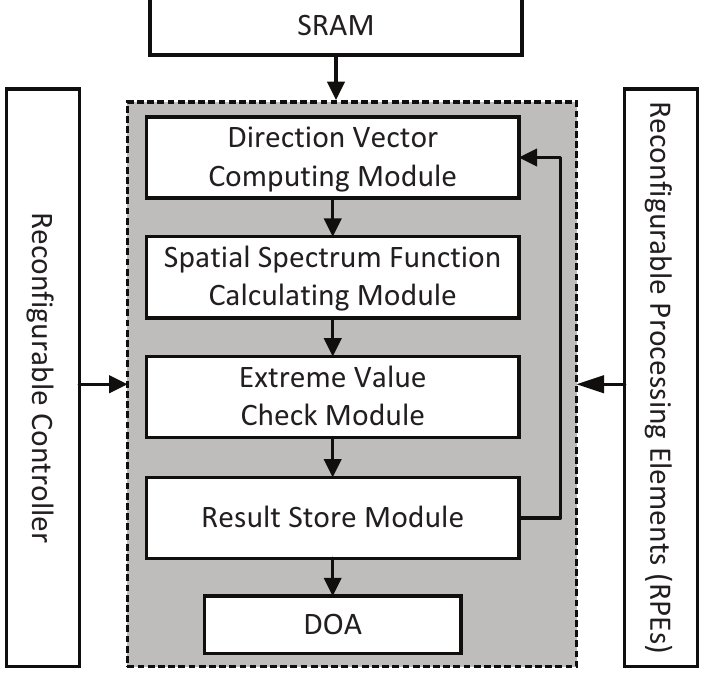
Figure 8. The block diagram of implementing the spectrum peak